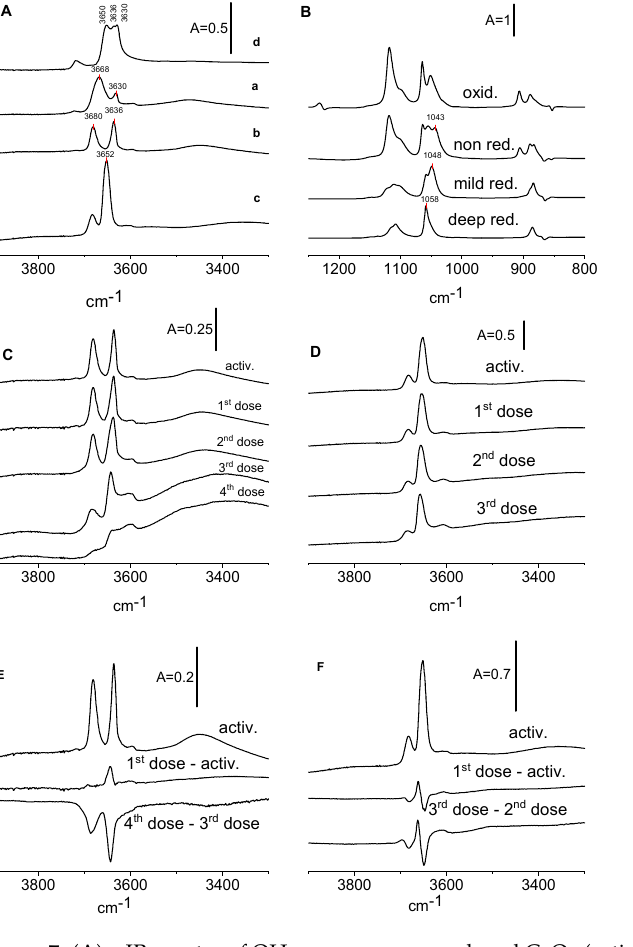
Figure 7. A – IR spectra of OH groups on CeO 2 non reduced (activated at 570 K) (a), mildly reduced (activated at 820 K) (b), deeply reduced by hydrogen at 770 K (c), and oxidized by oxygen at 670 K (d). B – ethoxy groups formed on CeO 2 non reduced, mildly reduced, deeply reduced and oxidized. C, D – OH groups on CeO 2 mildly reduced (C) and deeply reduced (D) upon the adsorption of ethanol . E – The spectrum of OH groups on mildly reduced CeO 2 and difference spectra: first dose minus activated sample as well as 4 th dose minus 3 rd dose of ethanol. F – The spectrum of OH groups on deeply reduced CeO 2 and difference spectra first dose minus activated sample as well as 3 rd dose minus 2 nd dose of ethanol.